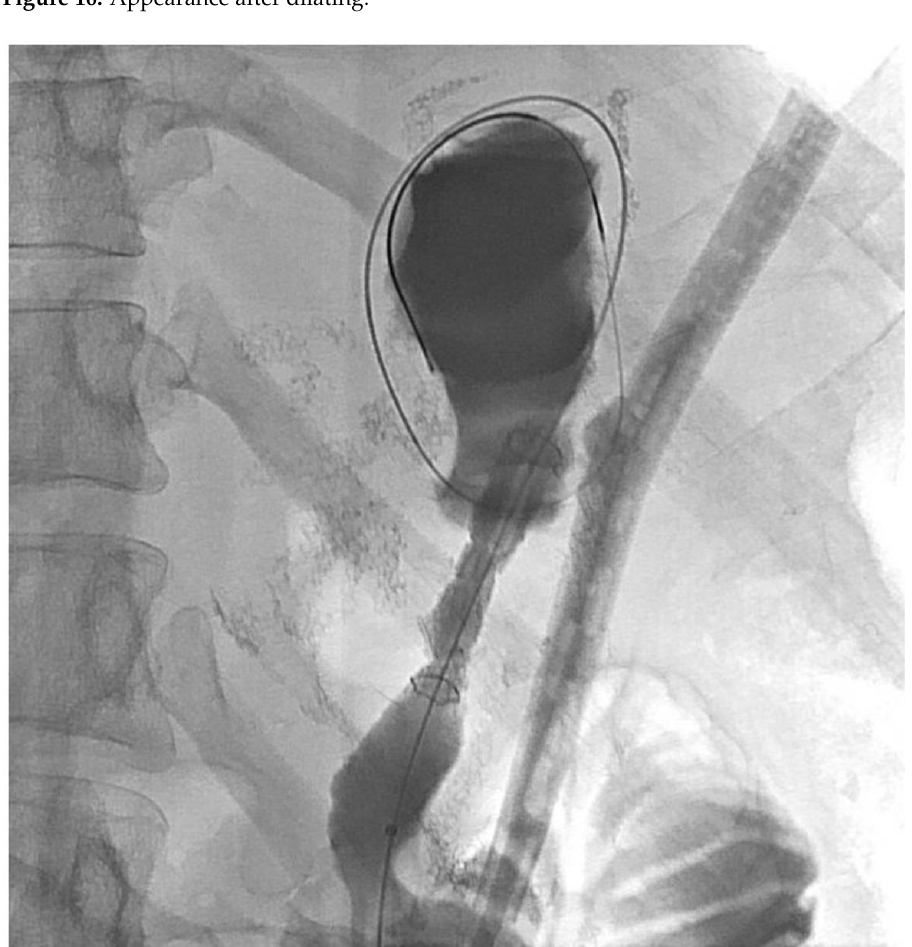
Figure 17. Covered stent insertion (fluoroscopic view).